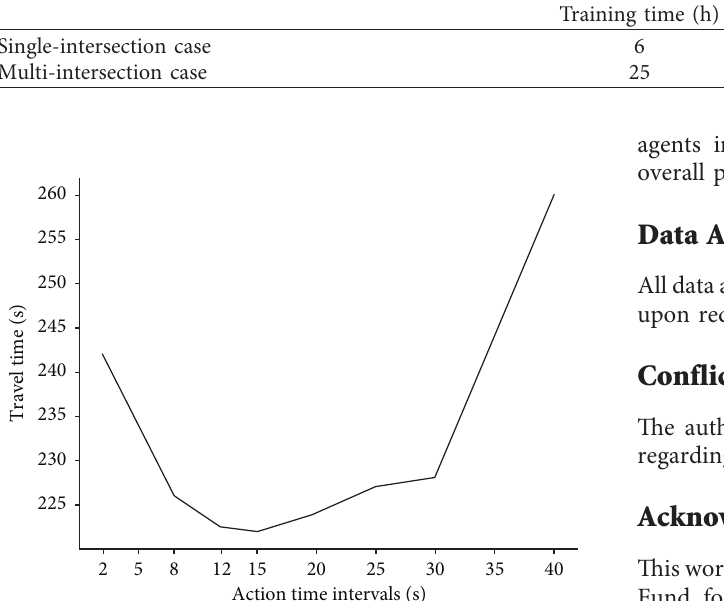
Figure 12: Travel time under different action time interval ∆ t .